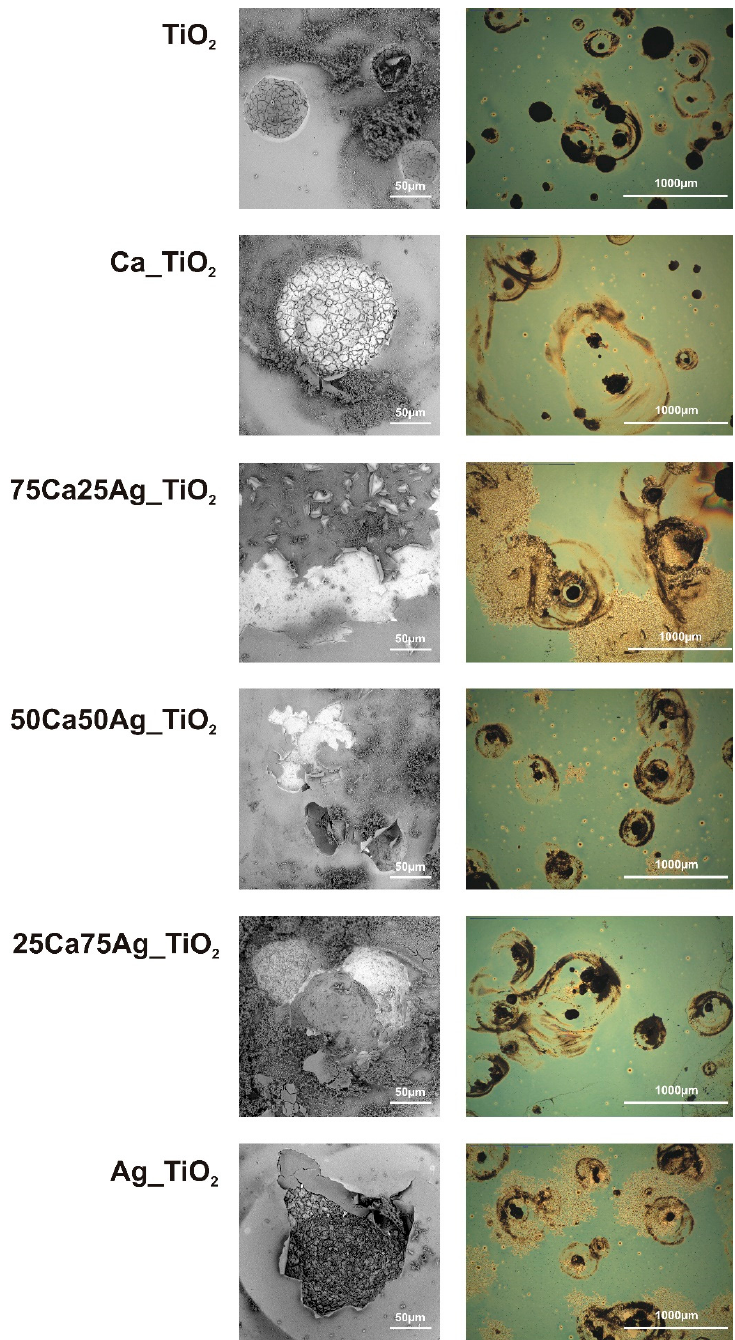
Figure 5. Post-polarization SEM images (1000× mag., bar 50 μ m) and optical microscopic images (50× mag., bar 1000 μ m).